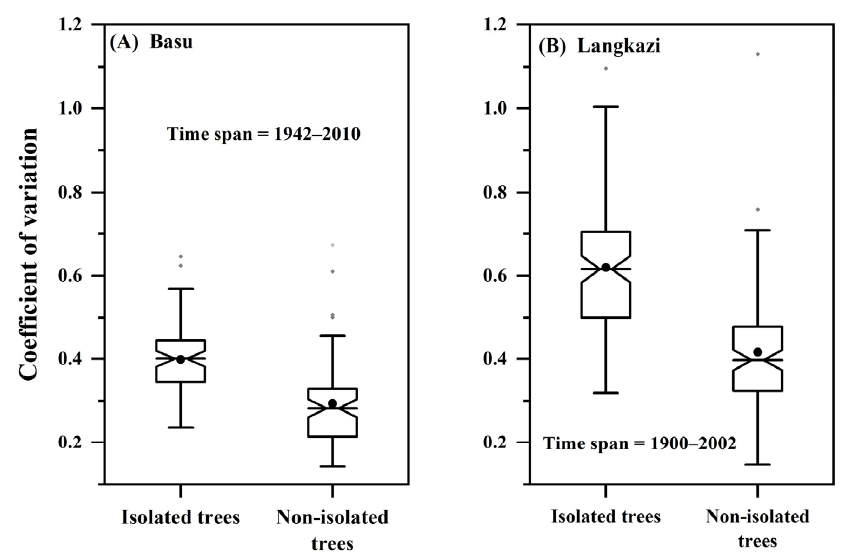
Figure 4. Coefficients of variation of ring-width data for the isolated trees and non-isolated trees in their common growth period of 1942–2010 for the Basu treeline ( A ) and 1900–2002 for the Langkazi treeline ( B ) in Tibet. The position of the notch represents the median value; the upper and lower edges of the box represent the 1st and 3rd quartiles; dots outside of the line represent outliers (be- yond 1.5 interquartile range of the box). If two notch boxes do not overlap, this indicates a significant difference between the two medians.